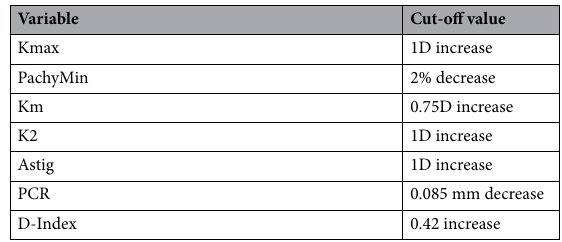
Table 5. Keratoconus progression parameters and respective cut-off values used to document progression. Kmax maximum keratometry, PachyMin minimum pachymetry, Km mean keratometry, K2 keratometry of steepest meridian, Astig corneal astigmatism, PCR posterior radius of curvature from the 3.0 mm centered on the thinnest point, D-Index Belin/Ambrósio D-Index, D diopter.